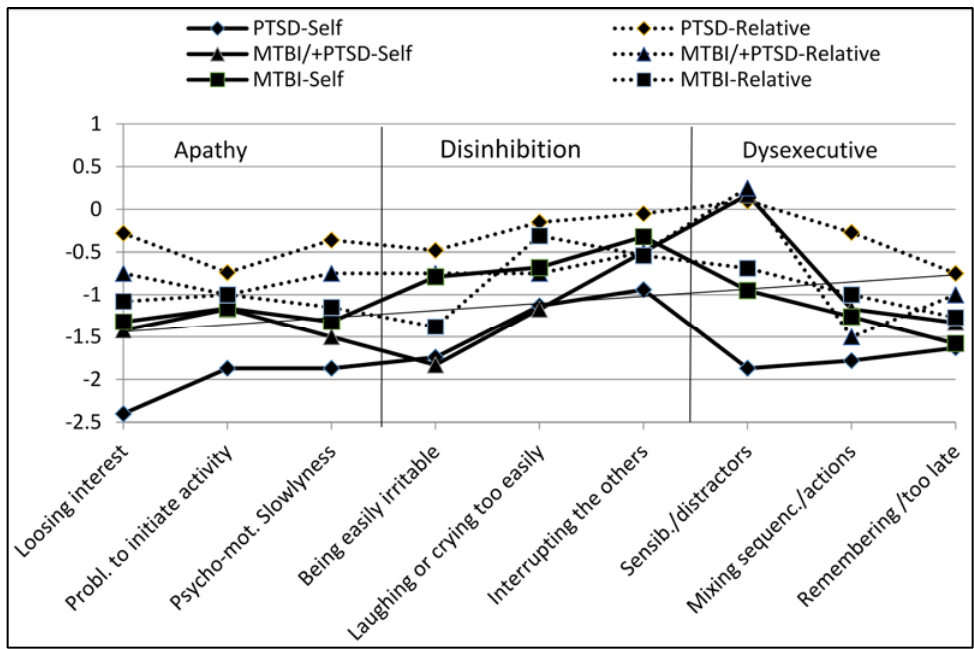
Figure 2. The most common changes reported by clinical groups on FrSBe